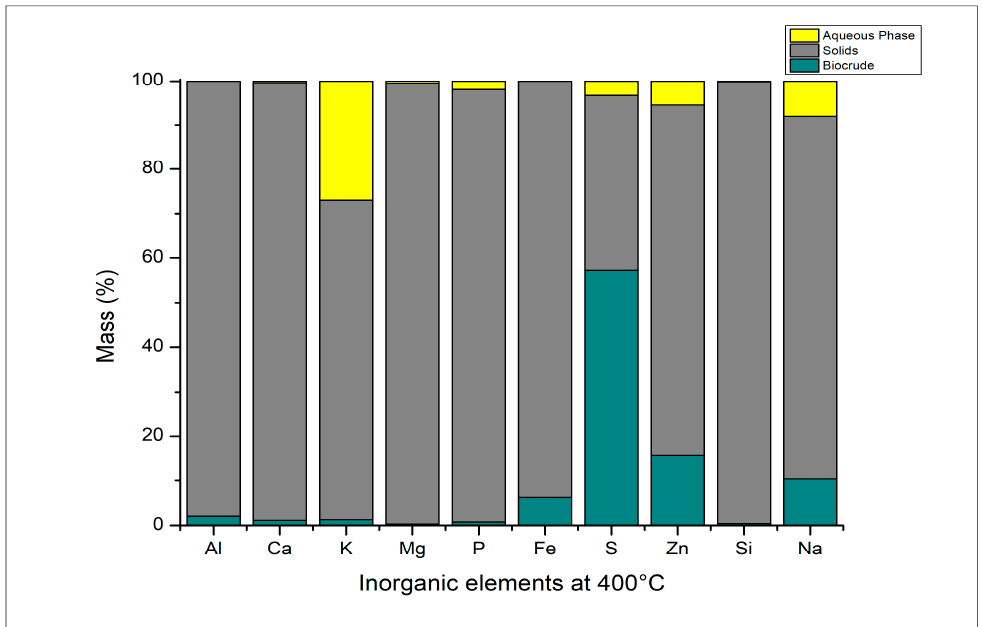
Figure 7. Mass distribution of inorganic elements at 400 ◦